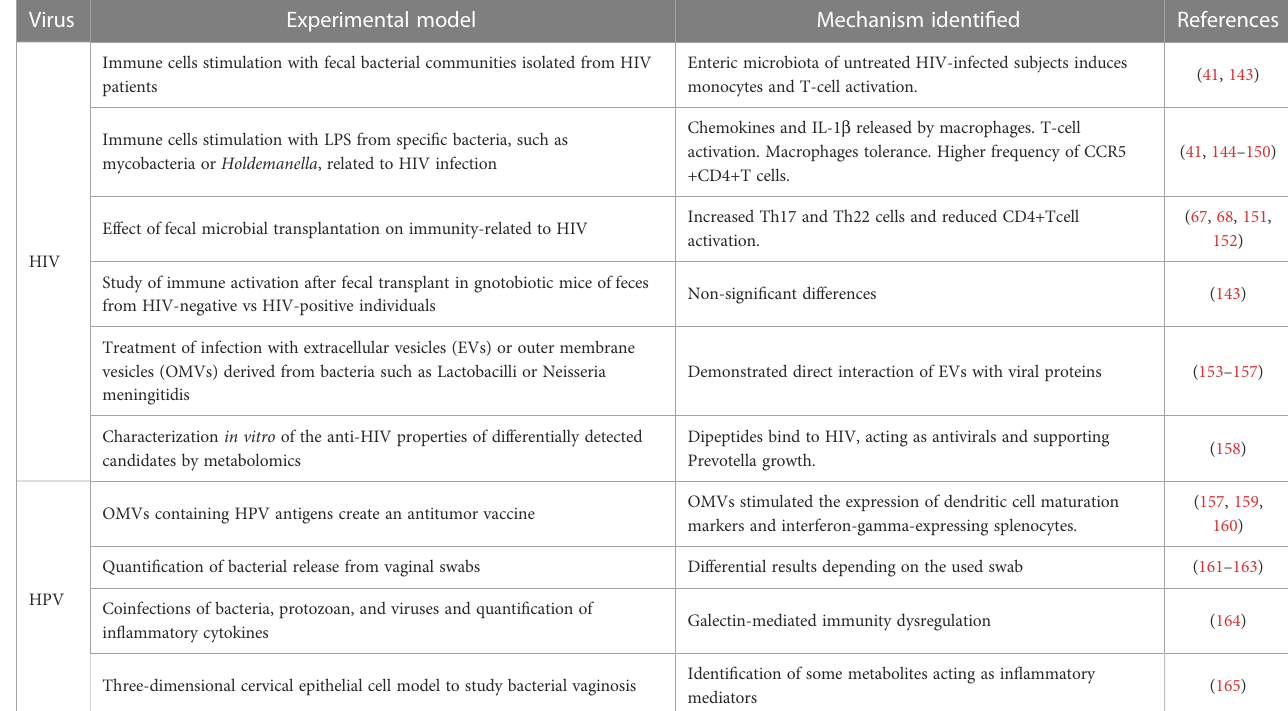
TABLE 2 Summary of the experimental models used to study the effects of microbiota on HIV and HPV infection. Virus Experimental